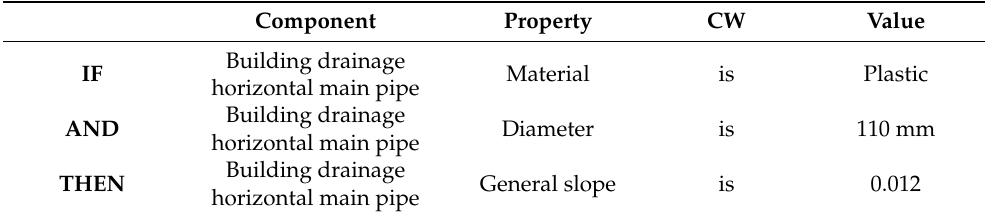
Table 2. The example of optimizing the rule about pipeline’s own properties.